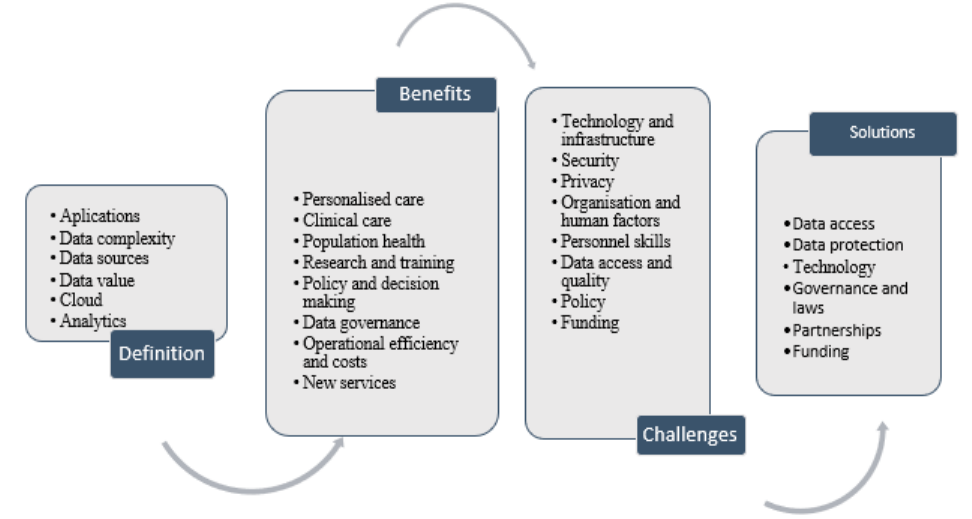
Figure 2. Social Representations of Big Data.